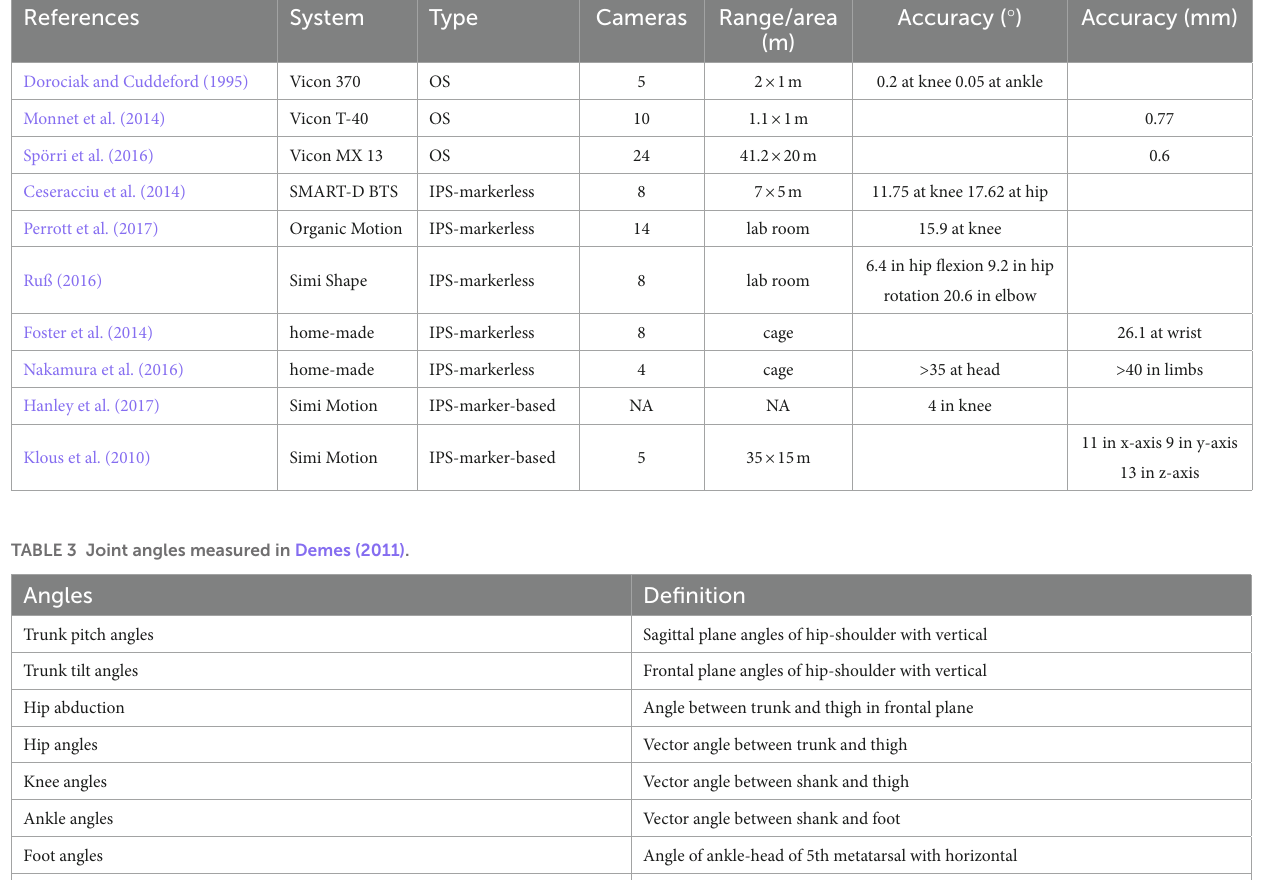
TABLE 2 The reported accuracy of MoCap